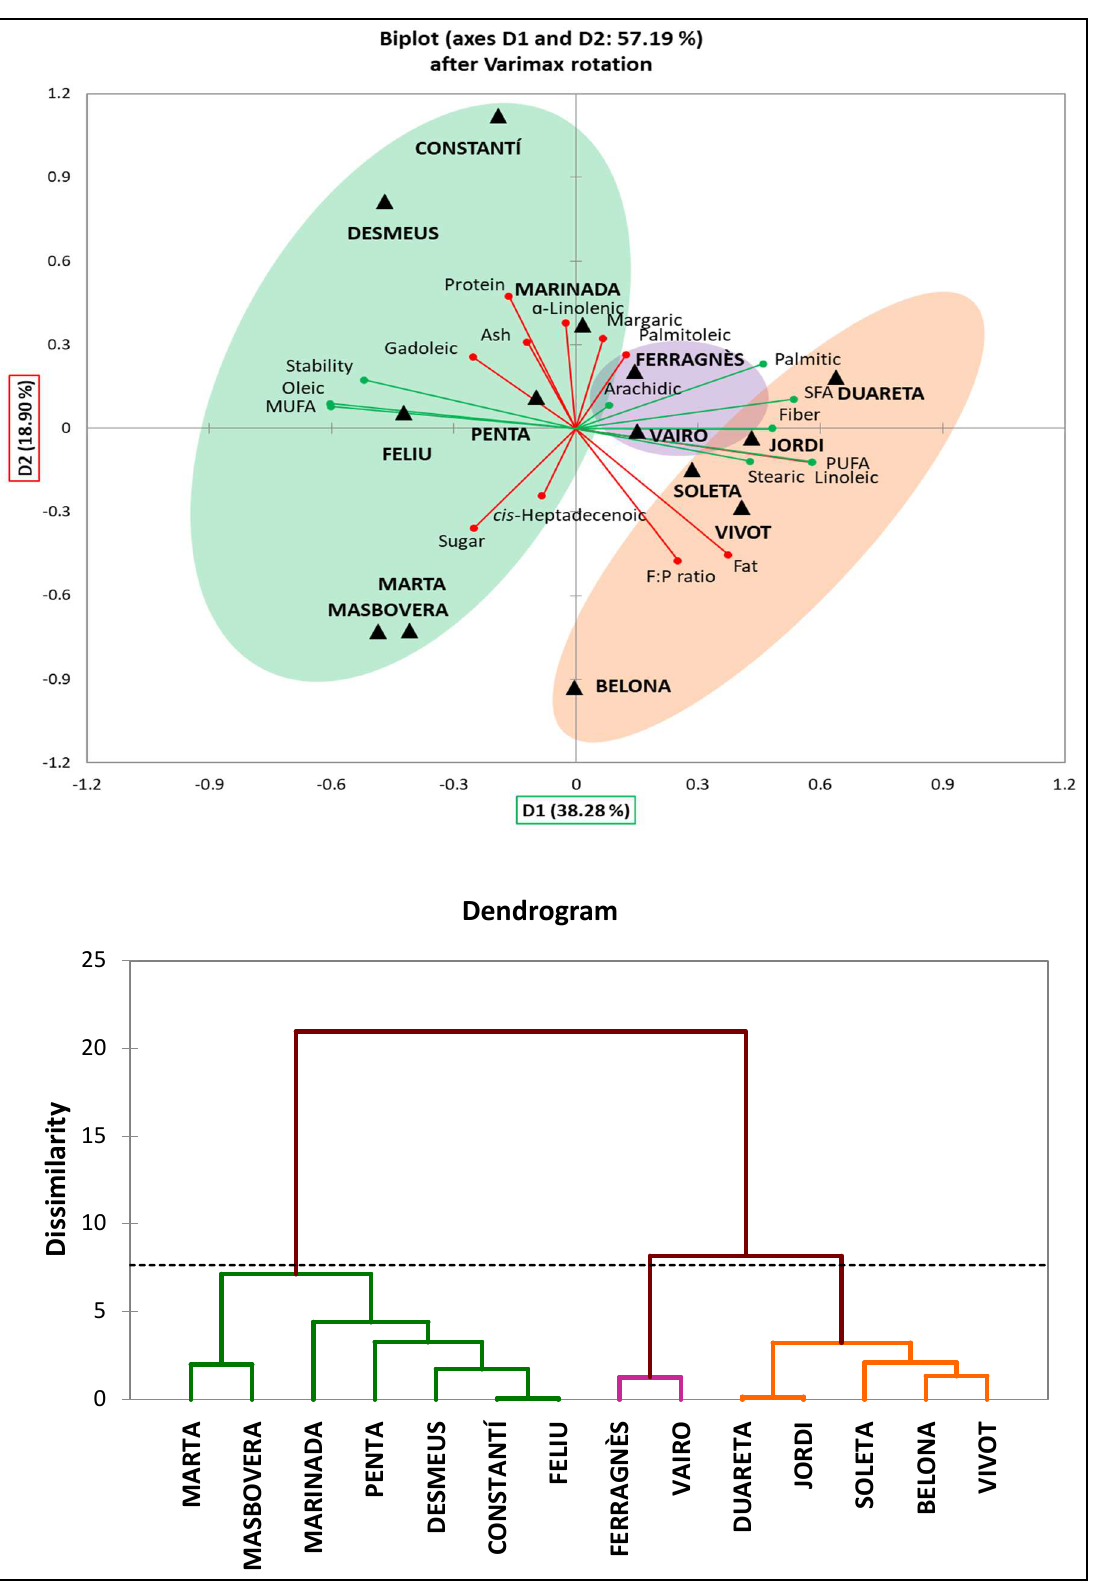
Figure 7. Principal Component Analysis (PCA) after Varimax rotation and Agglomerative Hierarchi- cal Clustering (AHC) on chemical parameters of kernel.